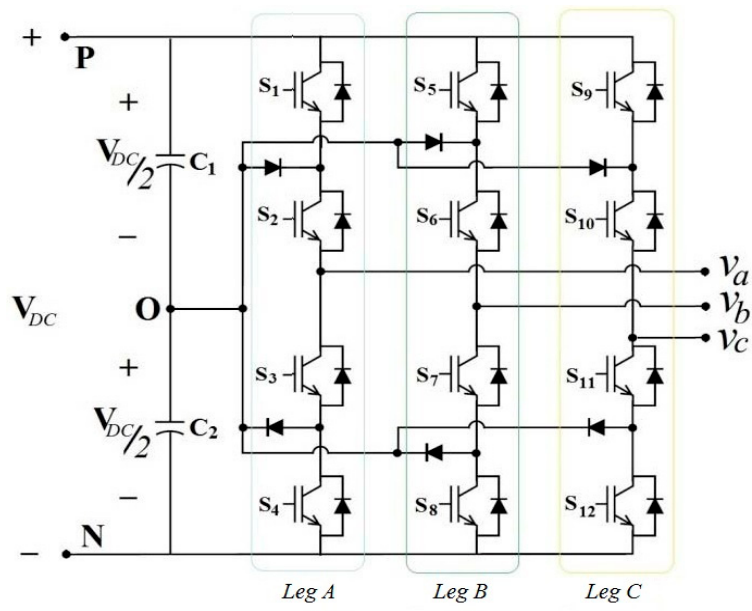
Figure 2. Three-level NPC inverter.